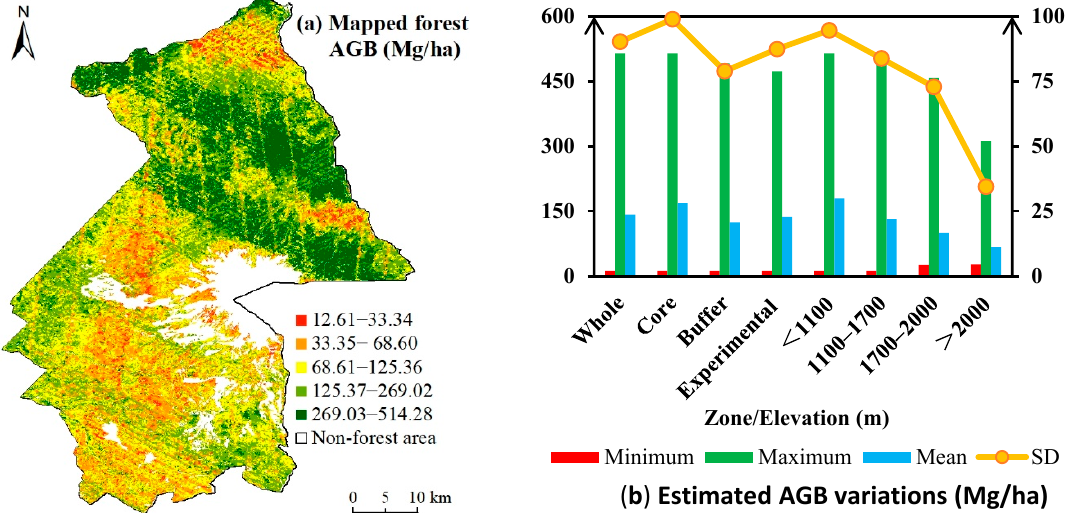
Figure 8. The spatial distribution of estimated forest AGB ( a ) and the estimated AGB variations of different elevation gradients and management zones ( b ) using object-based RF